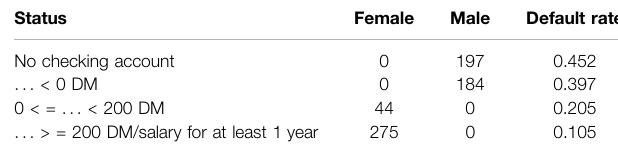
TABLE 3 | Construction of the variable gender for the training